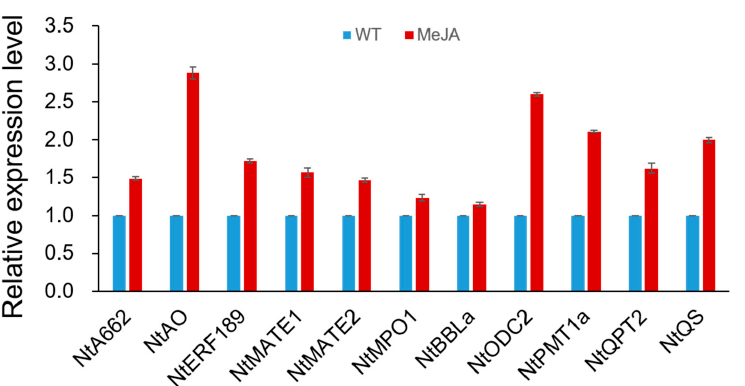
Figure 5. Relative expression of nicotine biosynthesis and transport-related genes 1 h after hairy roots were treated with 100 µM MeJA.